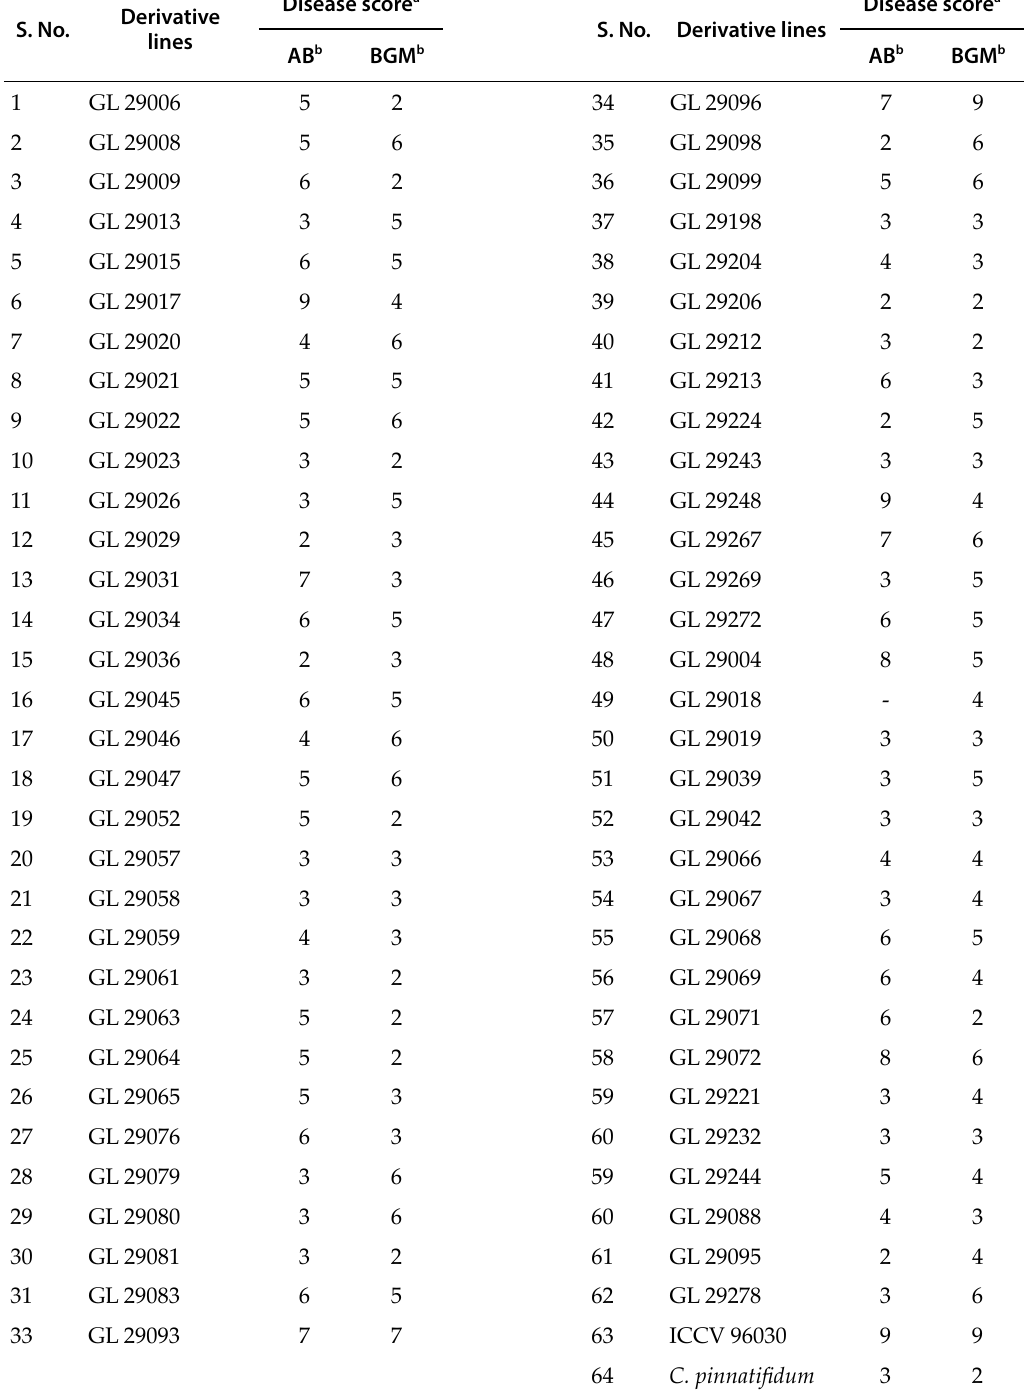
Table 3. Disease reaction of derivative lines from cross ICCV 96030 × Cicer pinnatifidum 188 . S.